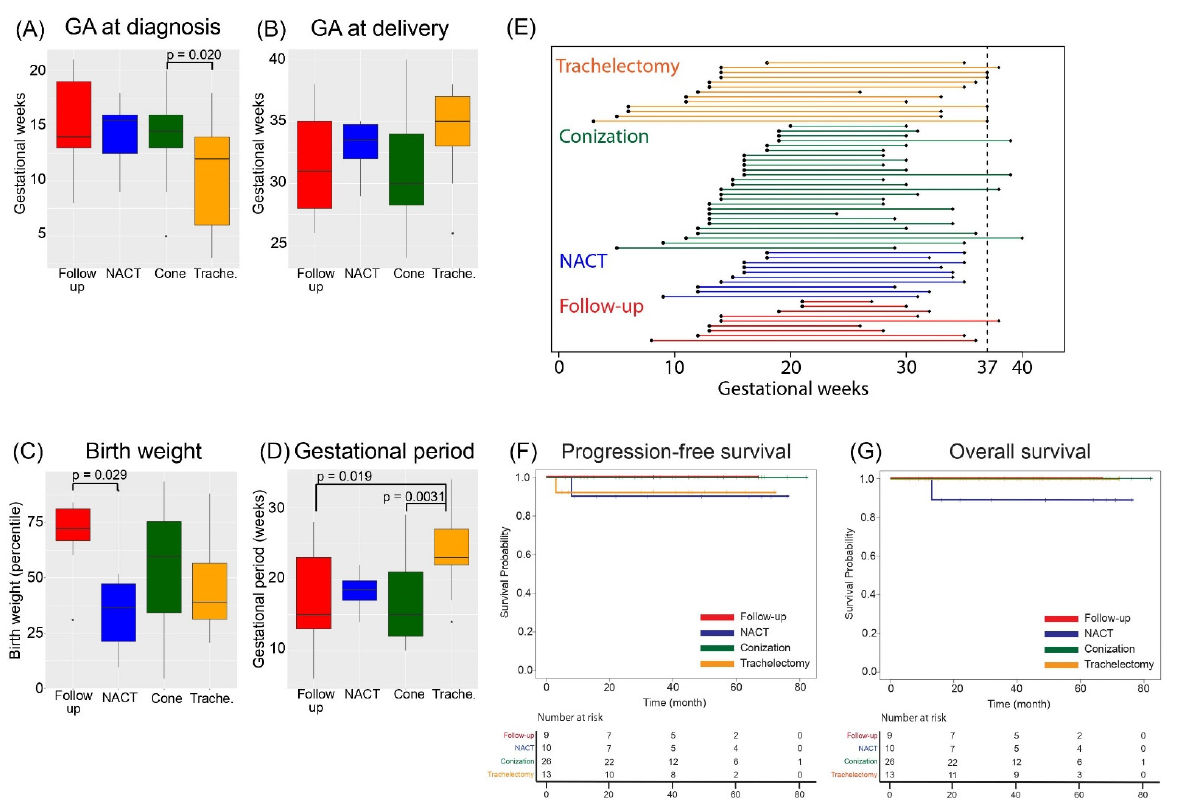
Figure 2. Differences in obstetrics and gynecologic outcomes among the four groups. ( A , B ) Comparison of gestational age at ( A ) diagnosis and ( B ) delivery. ( C ) Comparison of birth weight (percentile) at delivery among the four groups. ( D ) Comparison of the duration of pregnancy from diagnosis to delivery for each treatment group. ( E ) The duration of pregnancy from diagnosis to delivery for all cases. ( F ) The progression-free survival and ( G ) overall survival for each treatment group. GA, gestational age; NACT, neoadjuvant chemotherapy. For the infants, the birth weight percentile was 72.3 (IQR; range, 67–81) and 36.5 (IQR; range, 21–47) in the follow-up and neoadjuvant chemotherapy groups, respectively, with a significantly lower percentile in the neoadjuvant chemotherapy group ( p = 0.029) (Figure 2C). SGA was detected in 2/26 (7.8%) patients in the conization group and 1/10 (10.0%) patients in the neoadjuvant chemotherapy group. Next, the duration of pregnancy for each treatment group was compared among the four groups (Figure 2D,E). The duration for the trachelectomy group was significantly longer than those for the follow-up ( p = 0.019) and conization groups ( p = 0.0031). Finally, the oncologic outcome of each treatment modality was assessed by Kaplan– Meier survival analysis (Figure 2F,G). No significant differences in progression-free or overall survival were observed among the four groups. 4. Discussion Our multicenter retrospective observational study demonstrated the frequency of cervical cancer during pregnancy between 2012 and 2017. Although no significant differ- ence was observed, an increasing trend of cervical cancer during pregnancy was con- firmed, and we speculate that low cervical cancer vaccination and cervical cancer screen- ing uptake rates could be the underlying reasons. In Japan, repeated reports of pain and